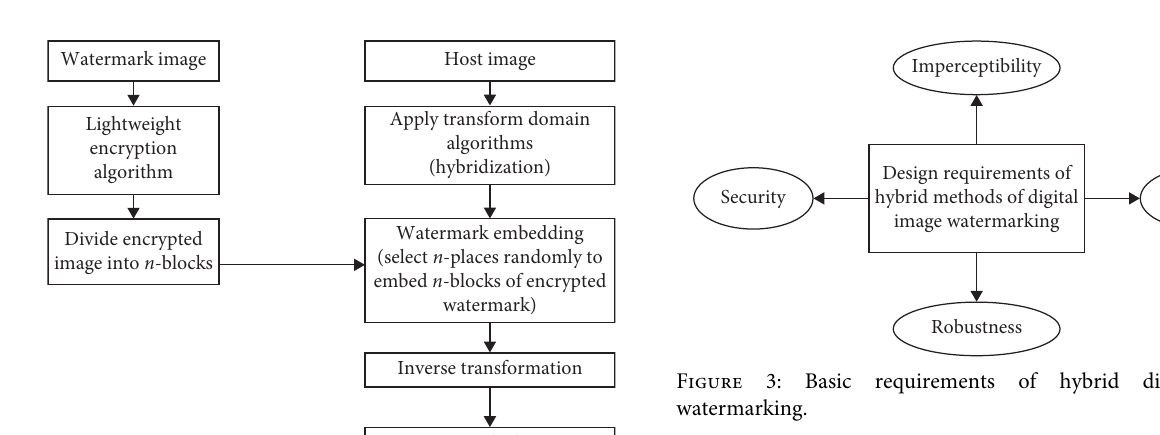
Figure 1: Watermark embedding and extraction.